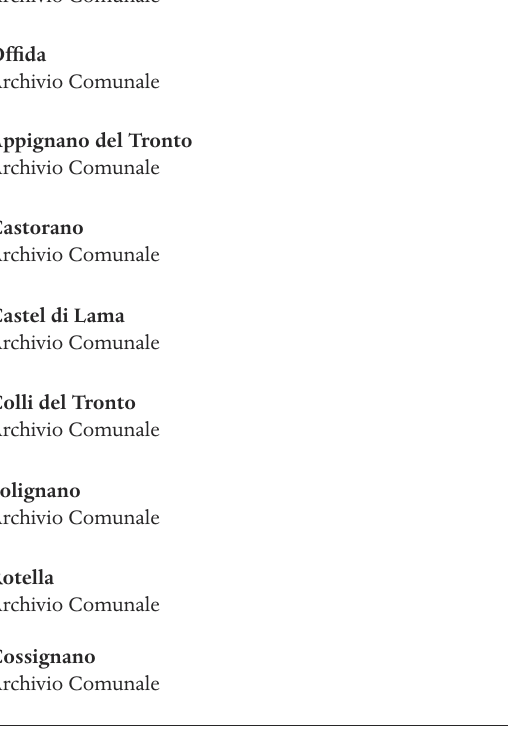
Figure 7. Intensity map resulting from the reappraisal carried out in the present